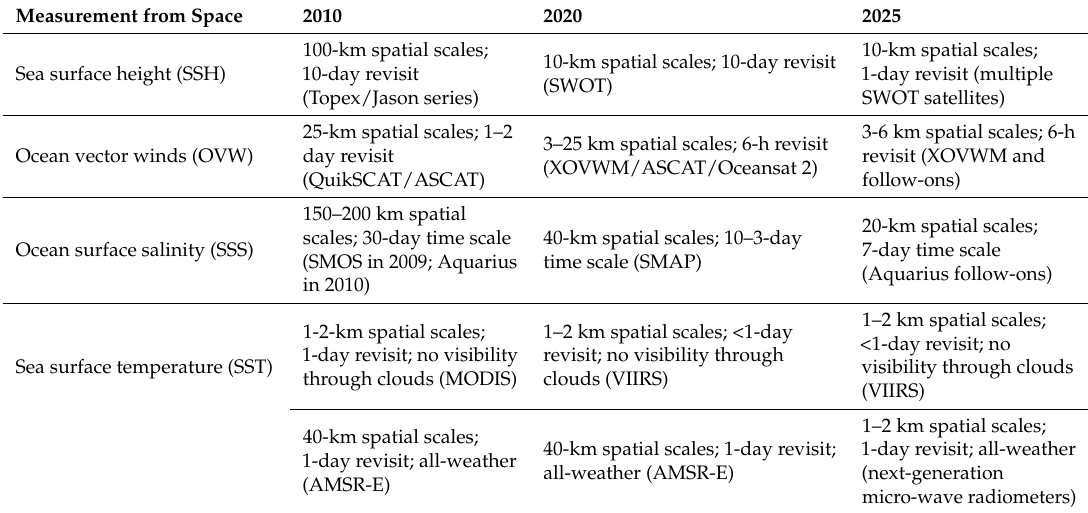
Table 4. State of ocean/sea measurements from space in 2010, 2020, and 2025 [110]. Measurement from